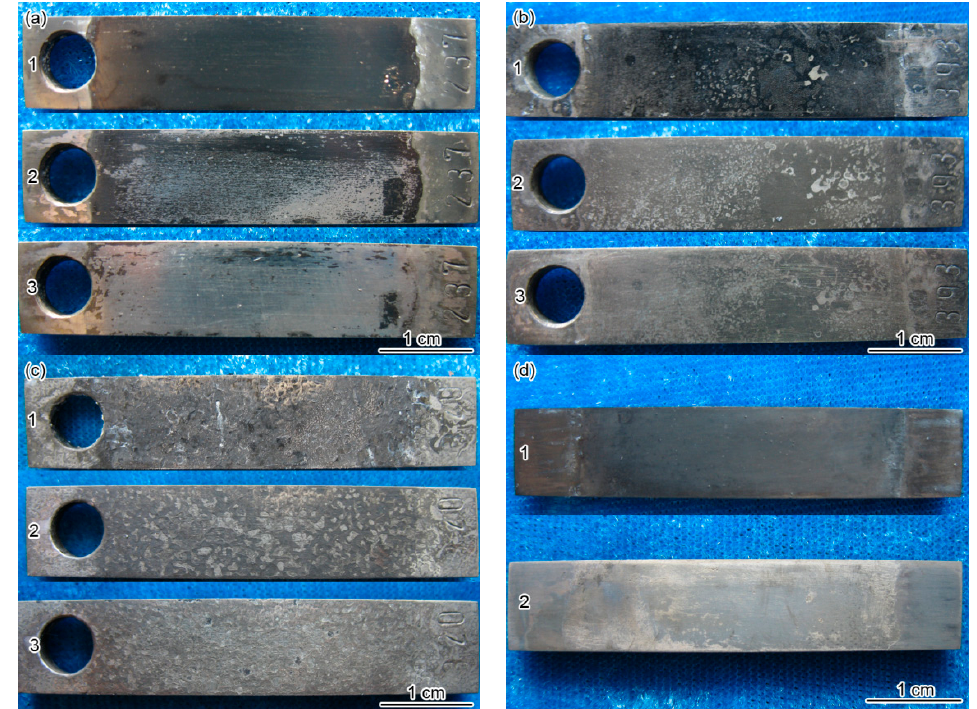
Figure 4. Macroscopic morphologies of ( a – c ) Ni-based alloy coating and ( d ) BG90SS steel exposed to the H 2 S/CO 2 environment for 168 h at different temperatures: ( a ) 60 °C; ( b , d ) 90 °C and ( c ) 140 °C. (1—before pickling, 2—after pickling, and 3—after descaling by the mechanical method).